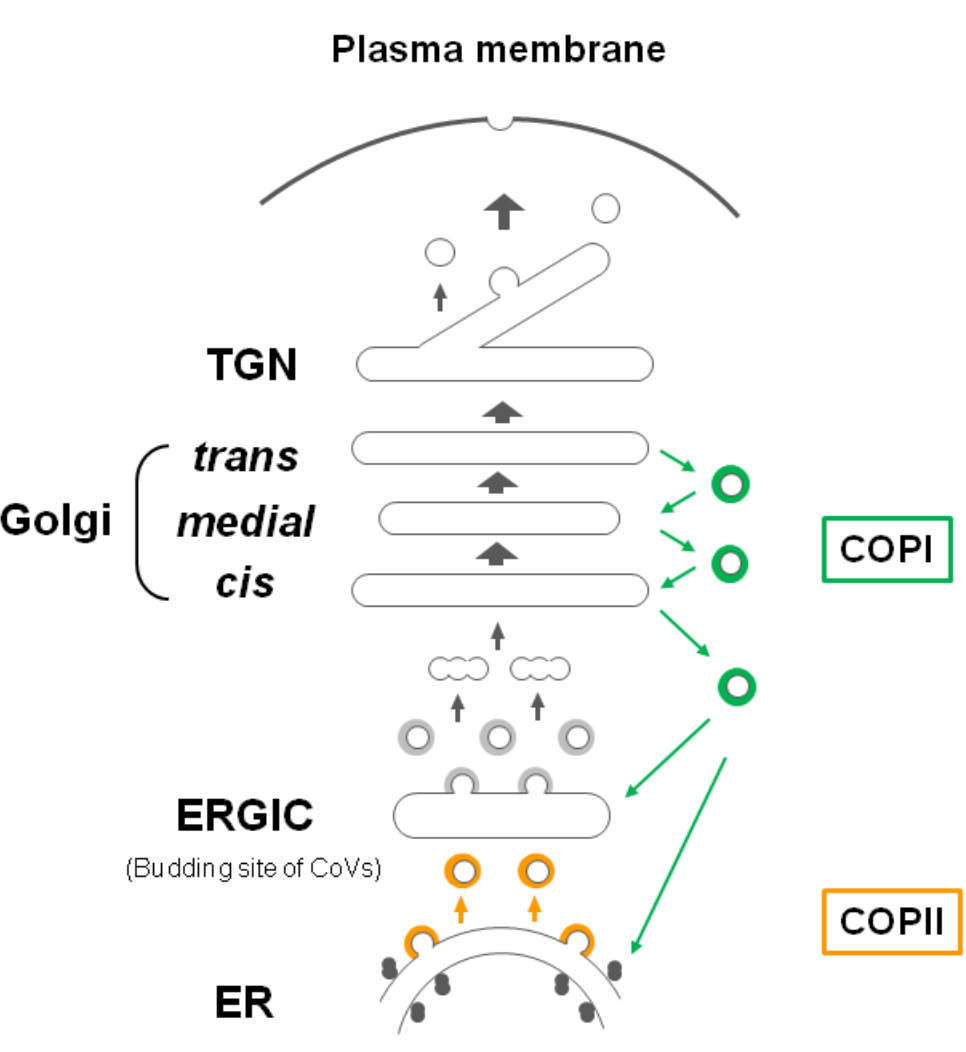
Figure 2. Cisternal maturation and stable (ER)-Golgi intermediate compartment (ERGIC) model. The protein in COPII vesicles (Orange) buds from ER-exit sites to the ERGIC, which is a stable compartment in mammalian cells, and subsequently to the cis -Golgi via a second undefined vesicular transport system (Grey) [53,61]. These vesicles fuse homotypically to construct new cis -cisternae, which are not stable compartments. They move and mature from cis to trans , and then breakdown into transport carriers at the TGN. Transport between the ER and Golgi is controlled by COPI vesicles (Green) in retrograde, and COPIl vesicles in anterograde, transport [55,56,58]. (Figure is modified, based on figure of Glick et al. , reference